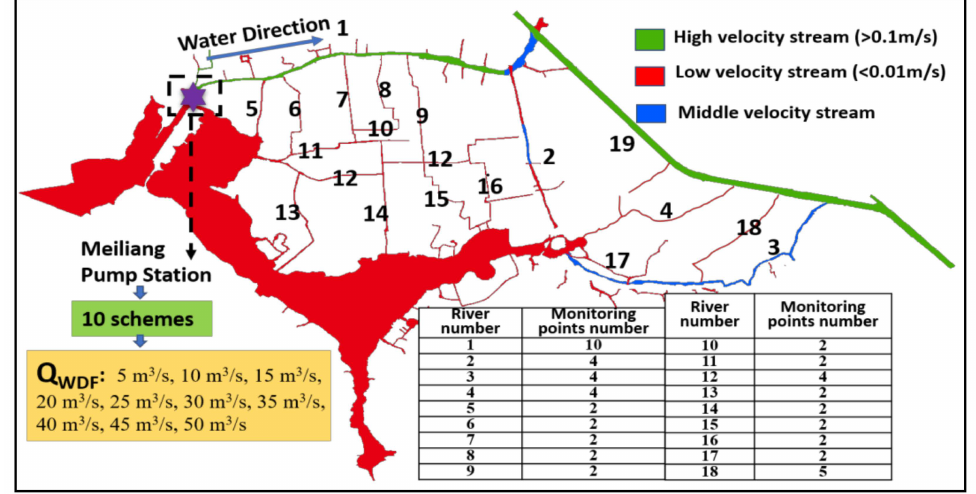
Figure 3. The diversion elucidating scheme and number of monitoring points in each river. These river numbers correspond to the river names in Figure